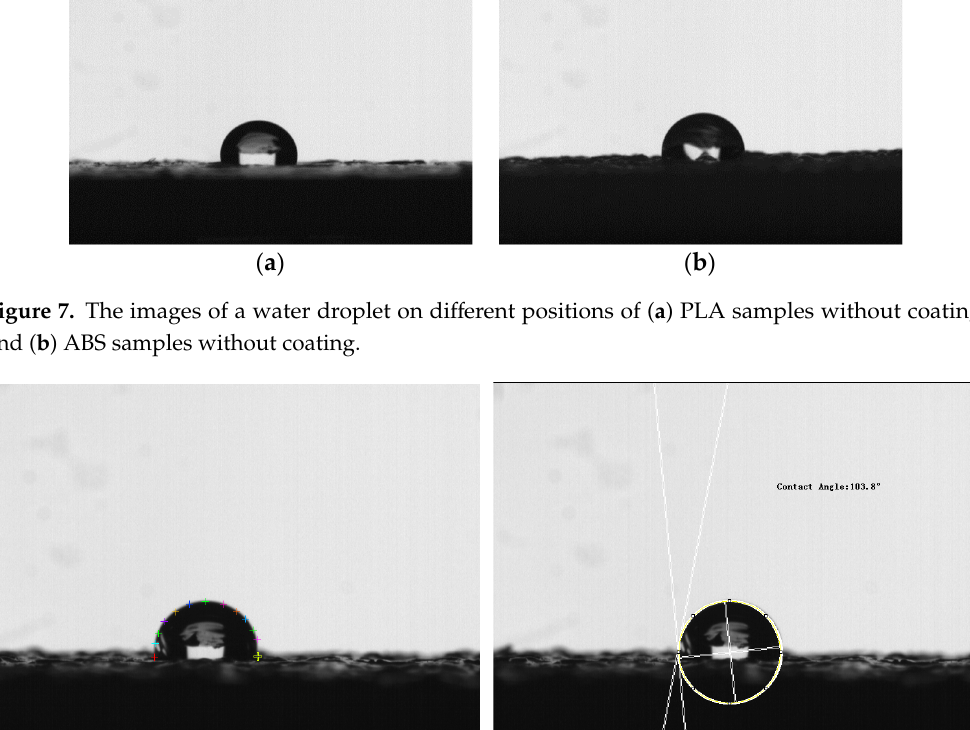
Table 4. Surface roughness of PLA and ABS tested parts.